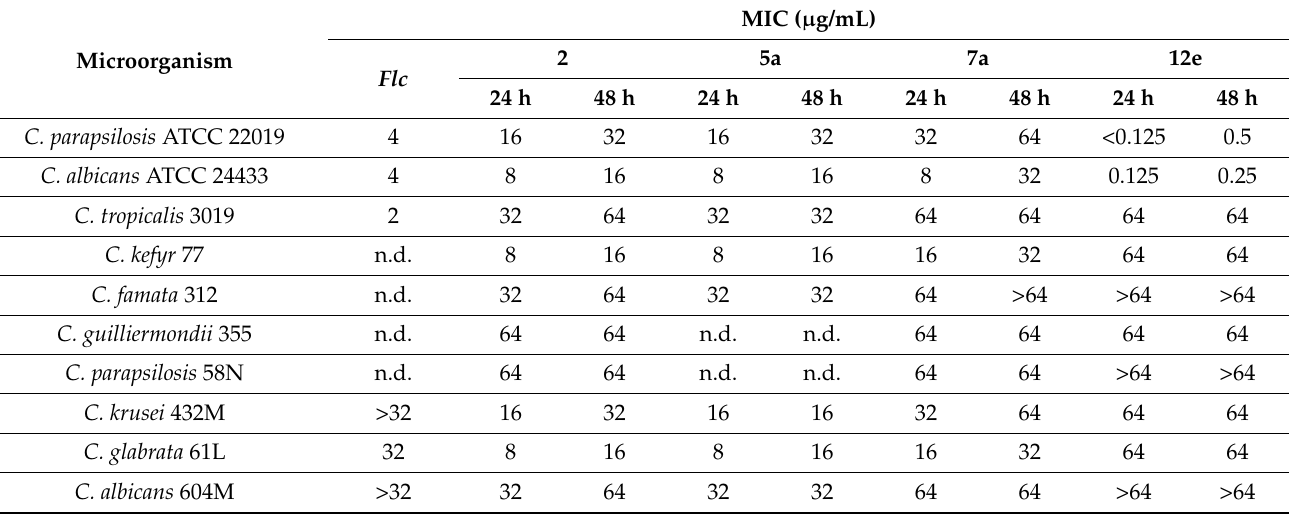
Table 4. Microbiological activity of some TZD derivatives on clinical strains of Candida spp fungi; n.d.—no data. Flc =